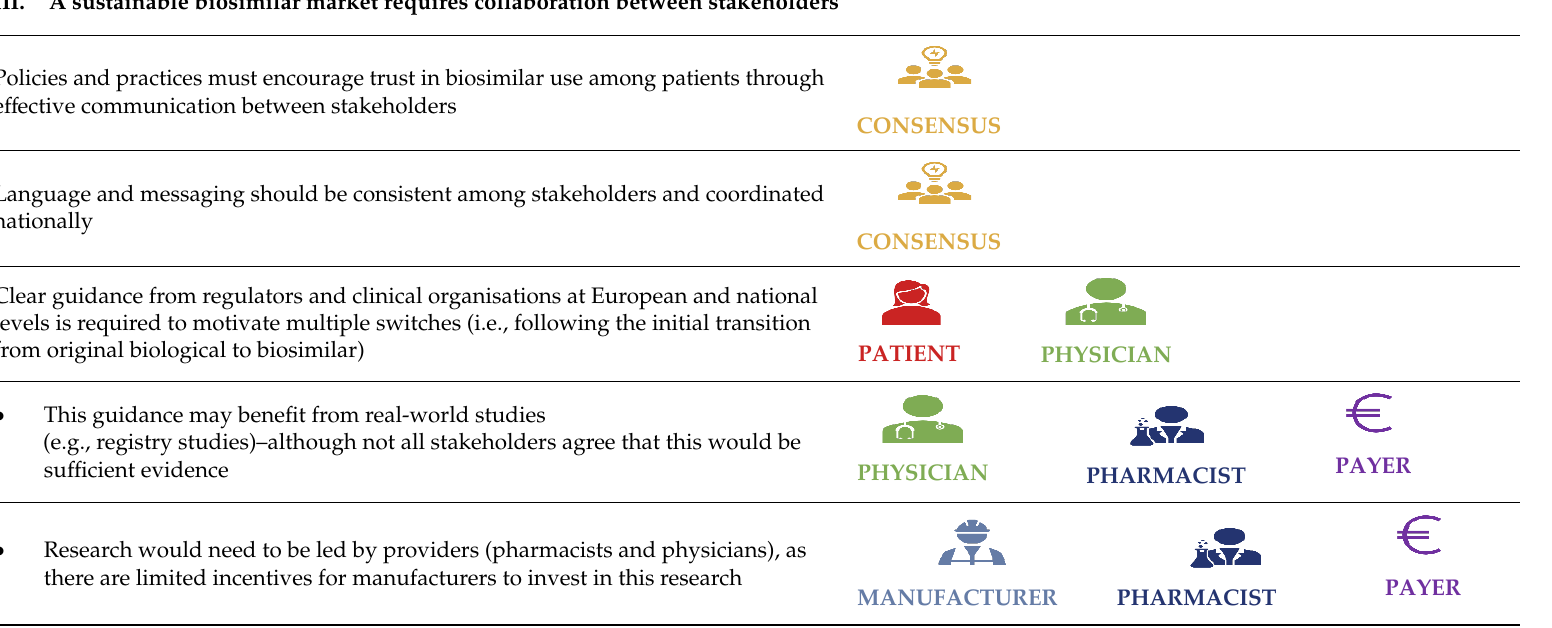
Table 1. Consensus on components of a sustainable biosimilar Table 1. Cont.